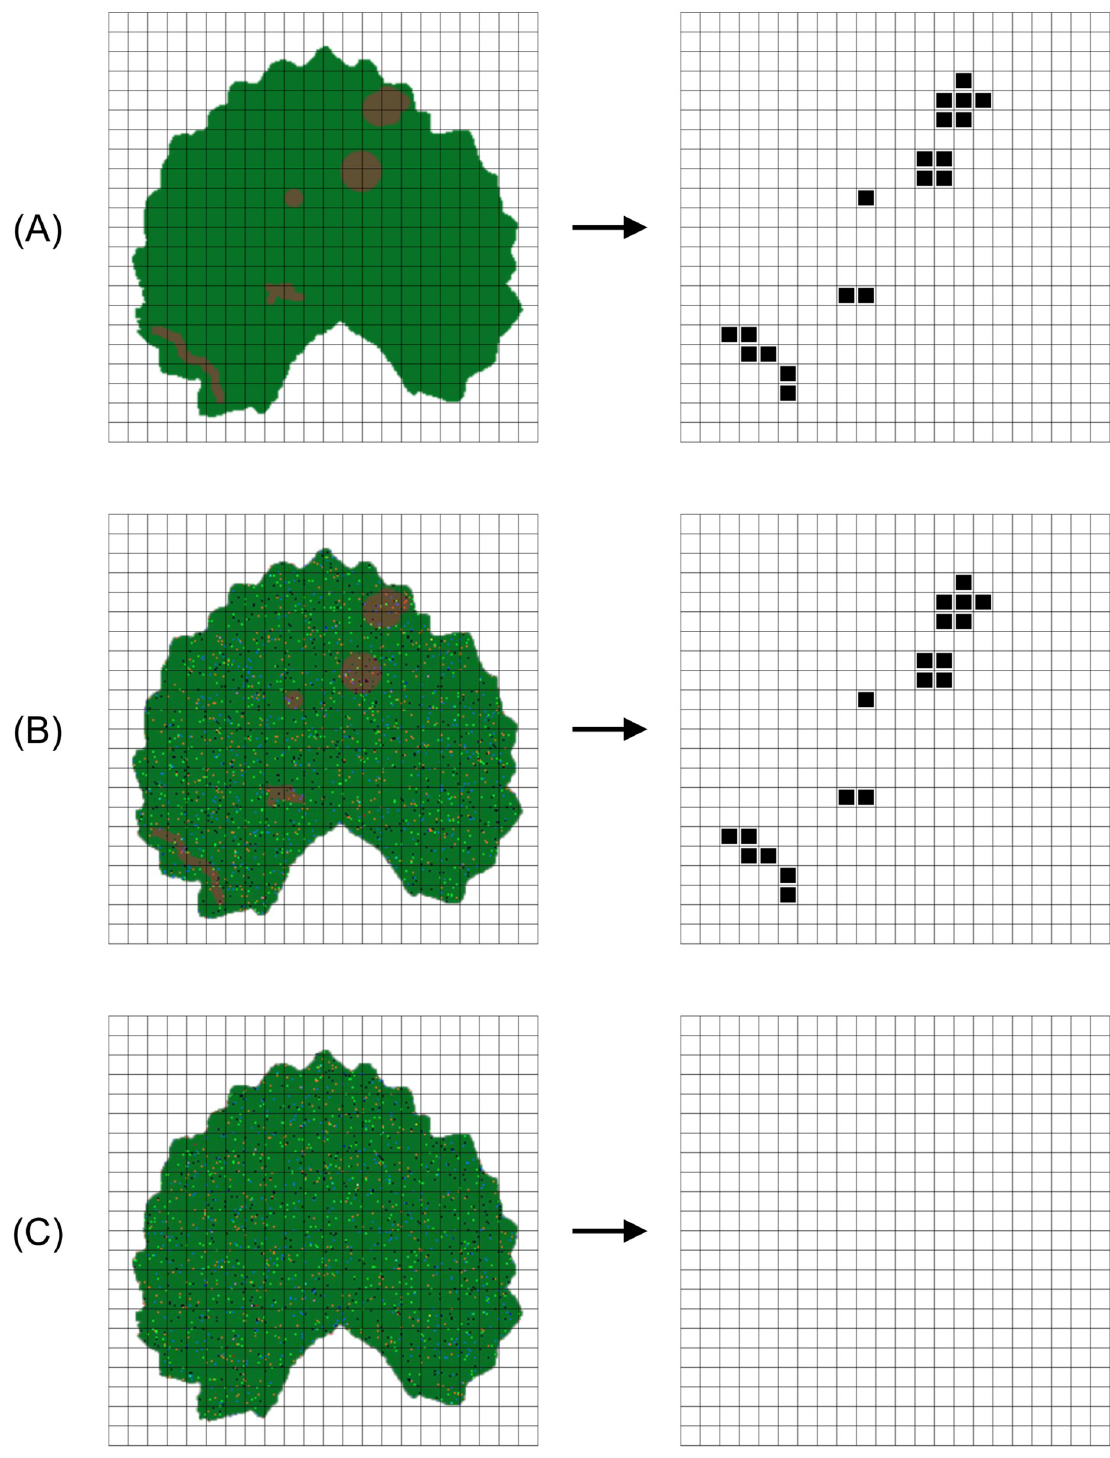
Fig 1. Desired output in different situations: The first column represents the initial (artificially created) image, whilst the second one represents the desired output matrix (active pixels in black). A, B: examples of correct detection when the input is a leaf image with disease symptoms upon pathogen infection (the second example considers a noisy input image). C: example of no detection when the input is a leaf image affected by impulse noise in healthy condition.